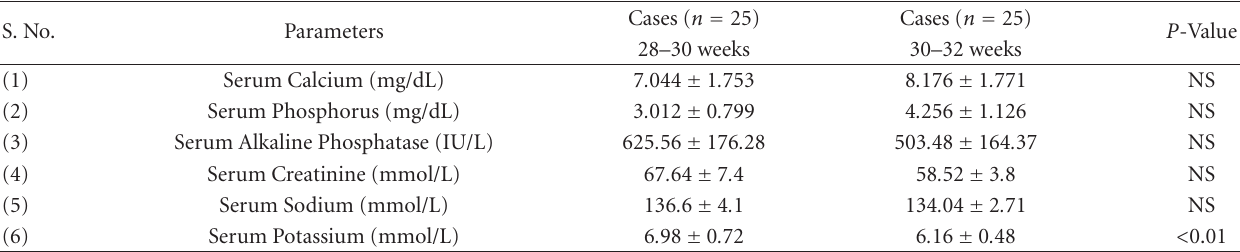
Table 3: Comparison of serum calcium, phosphorus, alkaline phosphatase, creatinine and electrolyte levels at 28–30 weeks and 30–32 weeks of gestational age in preterm